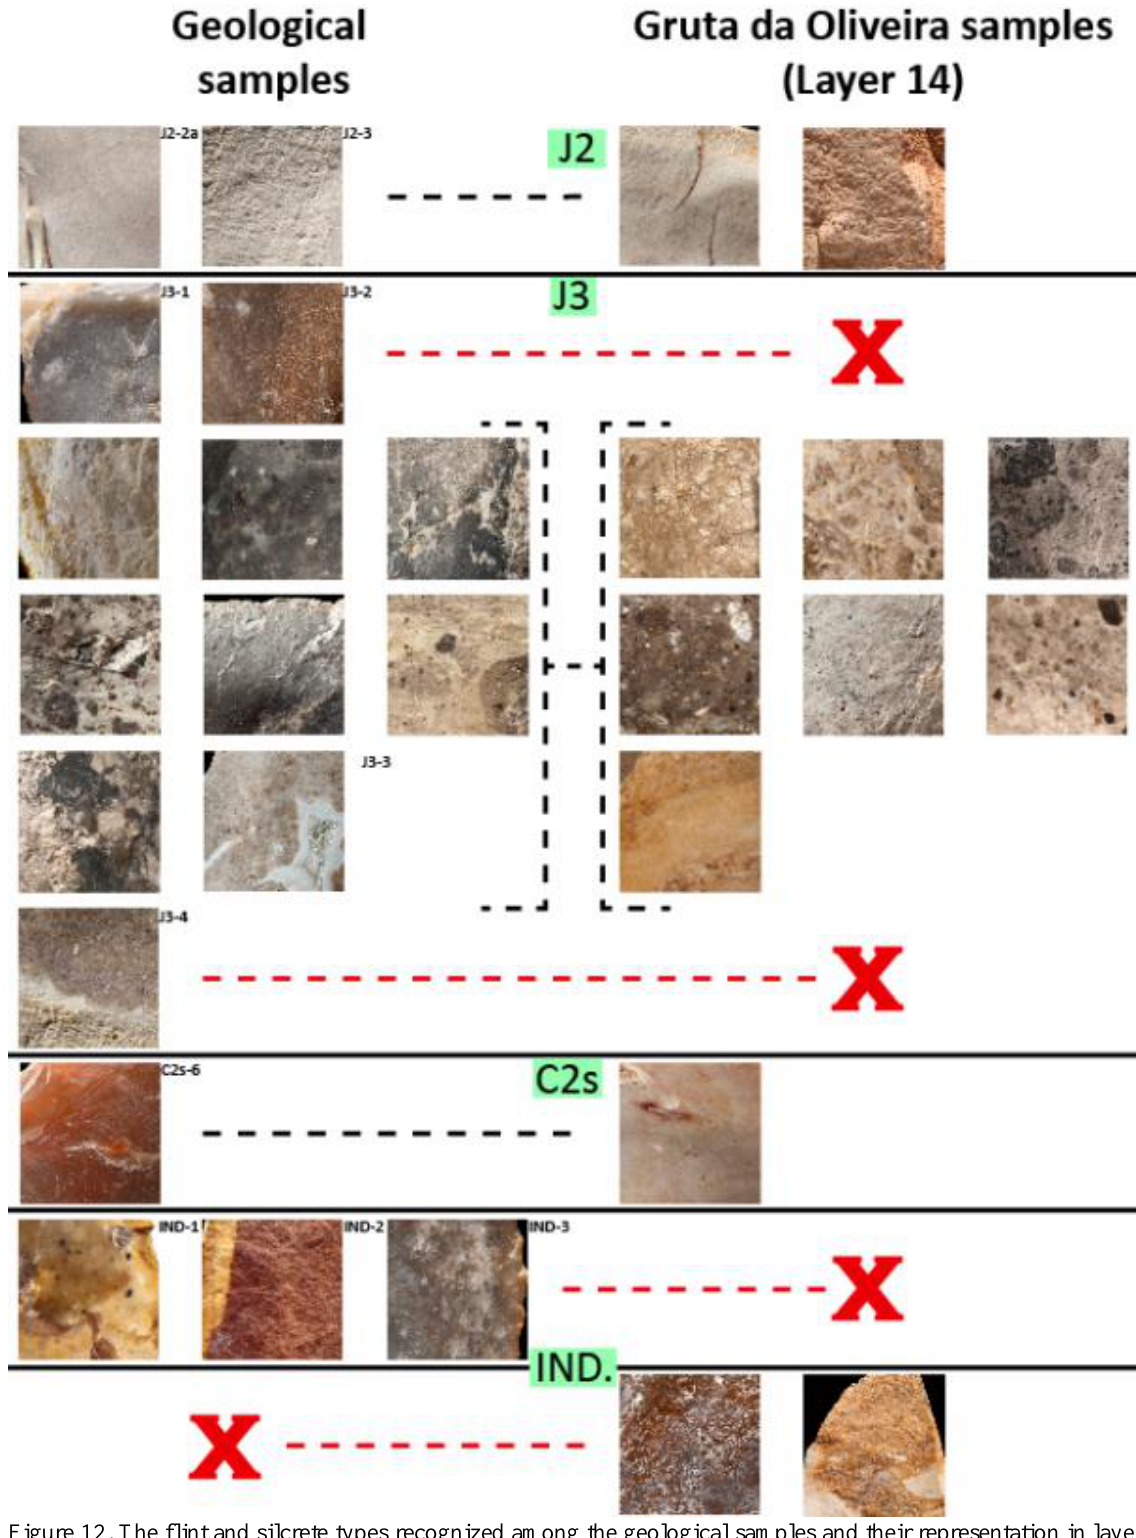
Figure 12. The flint and silcrete types recognized among the geological samples and their representation in layer 14 of Gruta da Oliveira. The cross means not present. Single image scale: 1 cm². (Photos by José Paulo